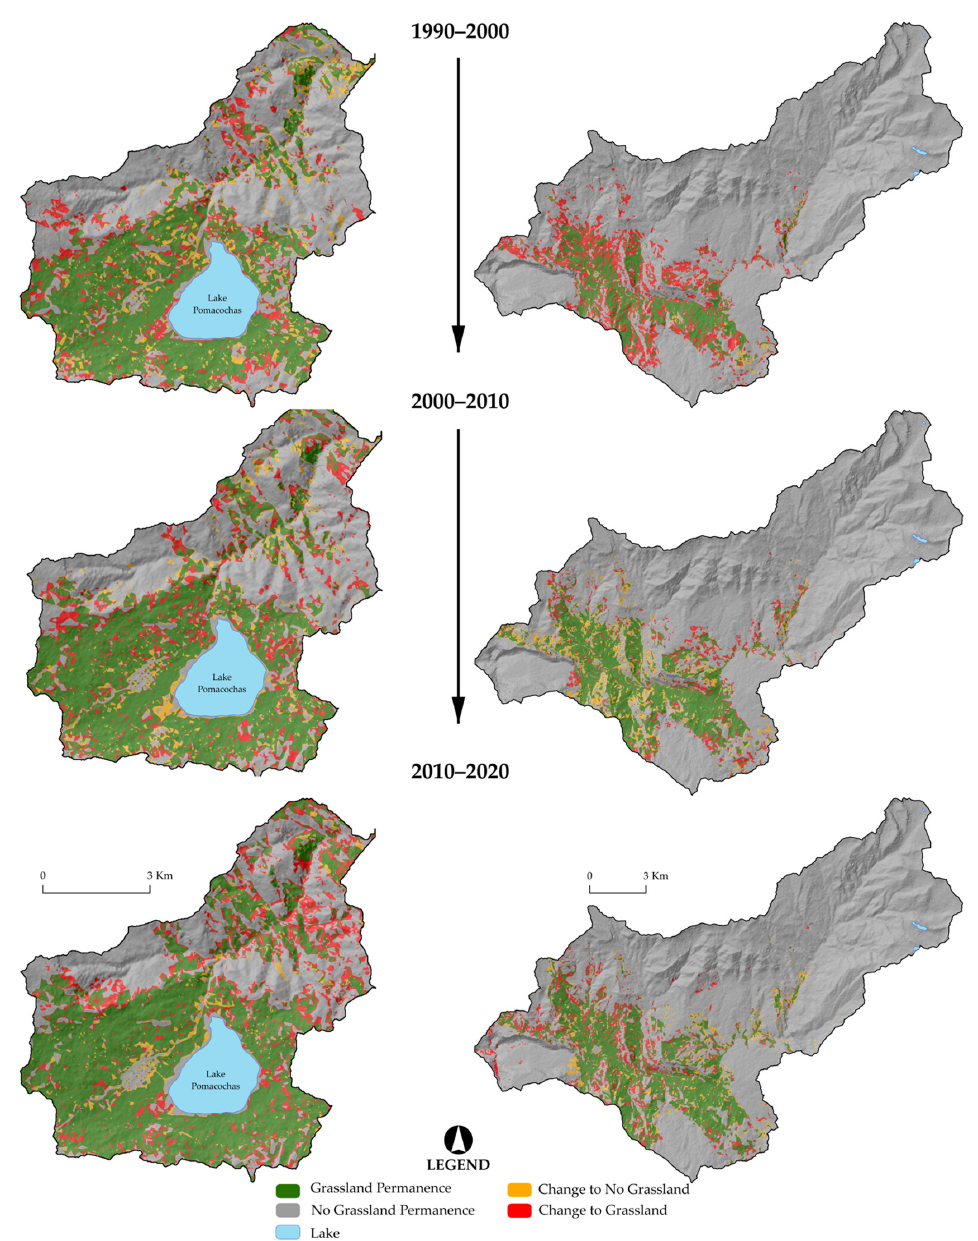
Figure 10. Maps of the processes of change and stability that occurred between 1990–2000, 2000–2010 and 2010–2020 in the micro-watersheds of Pomacochas and